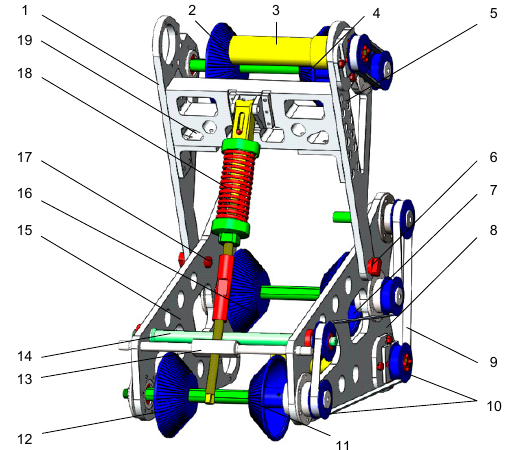
Figure 2. The structure of the climbing robot. 1—Left swing plate; 2—Left half-wheel B; 3—Motor 2; 4—Right half-wheel B; 5—Right swing plate; 6—Right hinge; 7—Right half-wheel A; 8—Right support plate; 9—synchronous belts; 10—Synchronous pulley; 11—Right half-wheel C; 12—Left half-wheel C; 13—Lower support bars; 14—stop lever; 15—Left support plate; 16—Left half-wheel A; 17—Left hinge; 18—Spring mechanism; 19—Upper support bars.